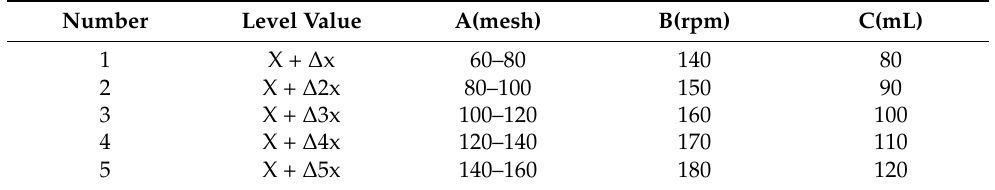
Table 2. Experimental level design for the steepest-climb experiment.